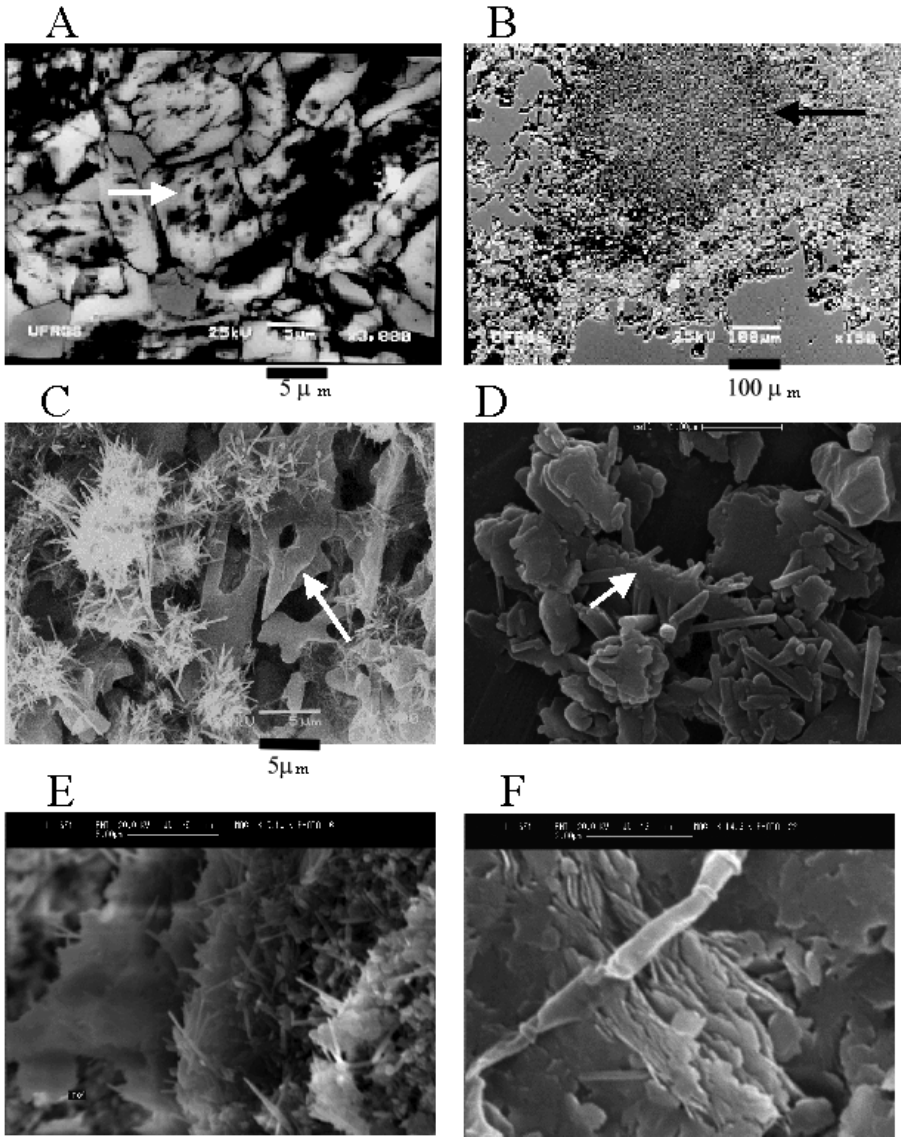
Fig. 7 – Microtextures of the clays: (A) inherited grains of K-feldspar at the base of Ceramarte mine showing "etch-pit formations"; (B) the arrow in the thin section photomicrograph points the spherulitic texture of the rhyolite; (C) in a small fragment, the porous structure of the spherulite, made of neddles of quartz, contains halloysite aggregates; (D) in the pallid zone of Ceramarte Mine it was observed that an aggregate of halloysite tubes apparently merge into kaolin stacks; (E) the stratification at Incepa saprolite is due to layers of halloysite tubes and spheres intercalated with kaolinite plates; (F) blocky structures in Oxford mine showed platy xenomorphic crystals of illite and also lath-shaped crystals with irregular ends. Photomicrographs D, E and F have graphic scale = 1 µ